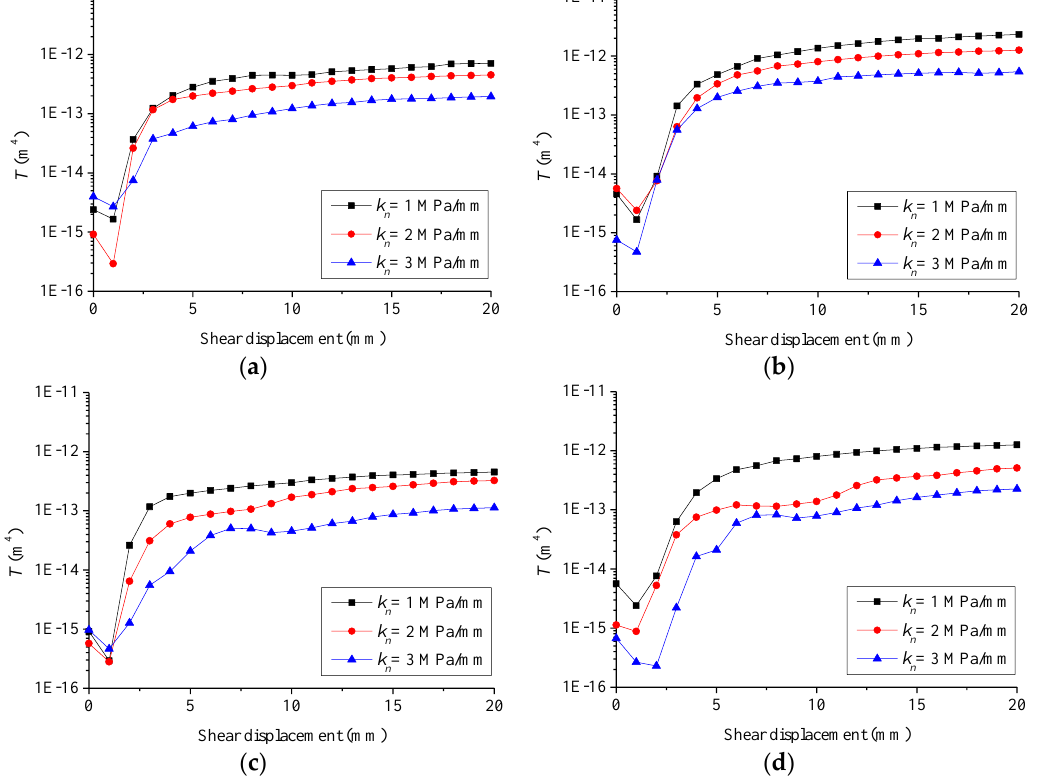
Figure 4. The evolutions of transmissivity of the replicas G1 and G3, during shearing, under different boundary conditions. ( a ) Transmissivity of replica G1, with different normal stiffness, under an initial normal stress of 1 MPa; ( b ) transmissivity of replica G3, with different normal stiffness, under an initial normal stress of 1 MPa; ( c ) transmissivity of replica G1, with different initial normal stresses, under a constant normal stiffness of 2 MPa/mm; ( d ) transmissivity of replica G3, with different initial normal stresses, under a constant normal stiffness of 2 MPa/mm.